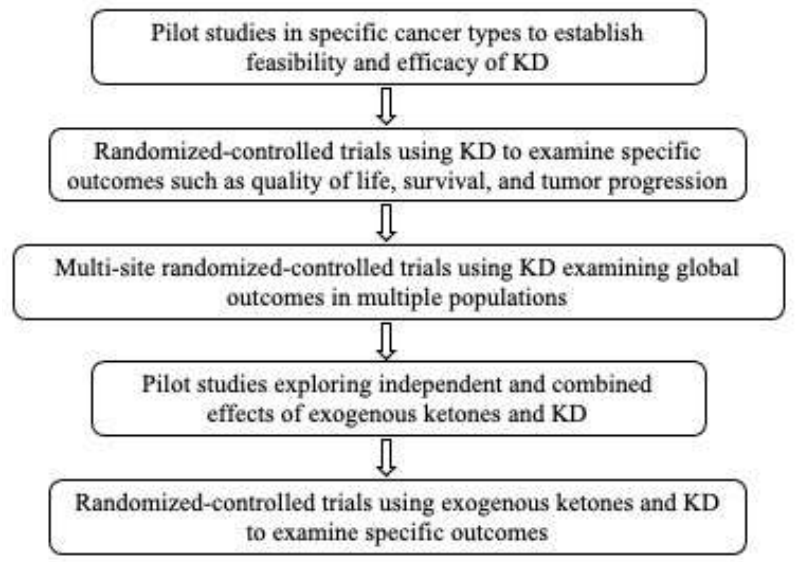
Figure 1. Sequential Research Recommendations for Investigating the Effects of the Ketogenic Diet (KD) on Human Cancers.